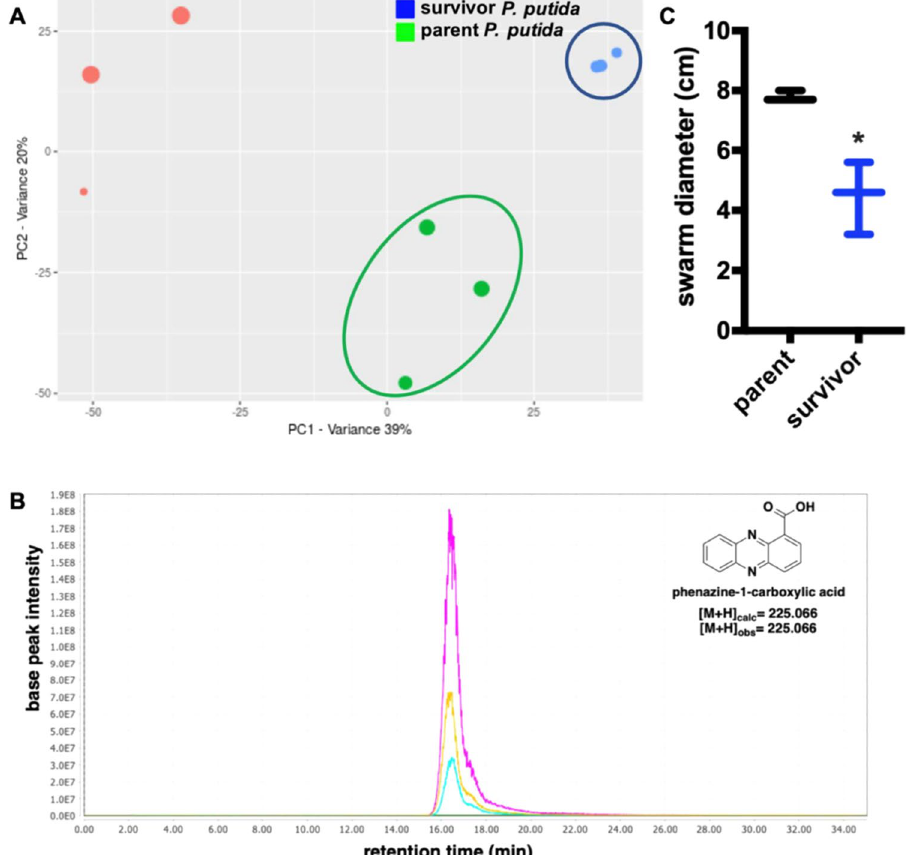
Figure 9. Phenazine-1-carboxylic acid production by survivor P. putida and potential contribution to predator avoidance trait. ( A ) Principal component analysis (PCA) score plot of untargeted mass spectrometry data from crude extracts of parent P. putida (green), survivor P. putida (blue), and media extracts with no bacteria added as a control (red). XCMS v3.7.1 was used to render the PCA score plot. ( B ) Extracted ion chromatograph (224.9–225.1 m/z) depicting presence of phenazine-1-carboxylic acid in extracts from survivor P. putida (n = 3; magenta, yellow, cyan) and absence in extracts from parent P. putida replicates (n = 3; red, blue, green (baseline)). Chromatograph rendered with MZmine v2.37. ( C ) Comparison of swarm diameters for C. ferrugineus cultivated on filter-sterilized supernatants from parent P. putida and survivor P. putida cultivation broths (n = 3; p = 0.039). Statistical significance calculated from an unpaired t test with Welch’s